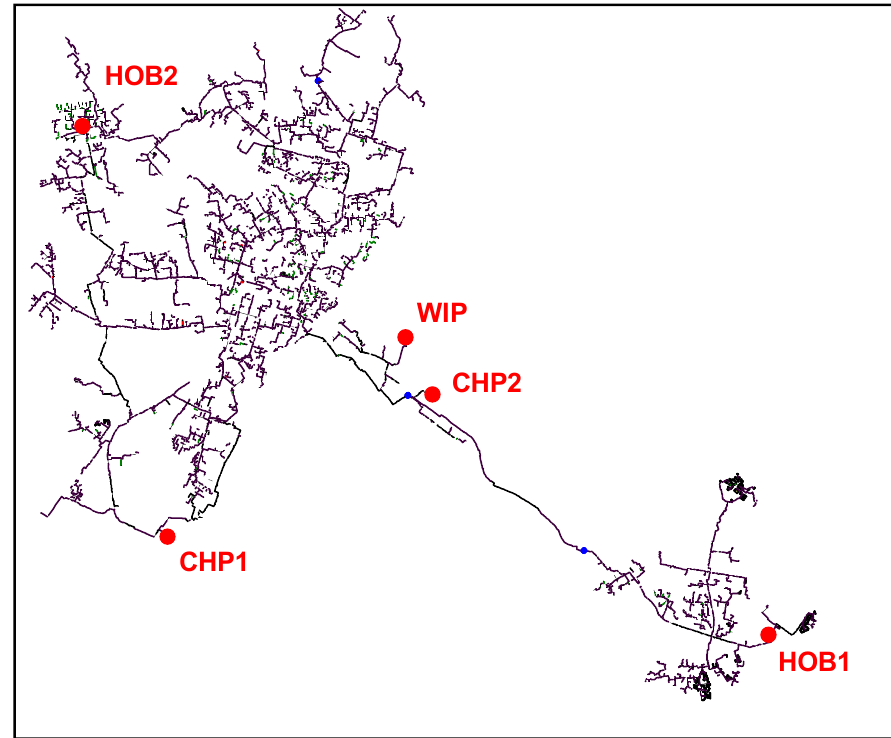
Figure 1. Map of the district heating system (DHS) in Szczecin with its five heat sources marked. CHP, combined heat and power plant; HOB, heating only boiler; WIP, waste incineration plant. Replenishment of network water for the DHS in Szczecin is carried out in the HOB2 plant through a make-up water station. Other heat sources are also equipped with make-up water stations, but they are activated when the DHN enters an emergency state as a result of a failure and rapid replenishment of water in the system is